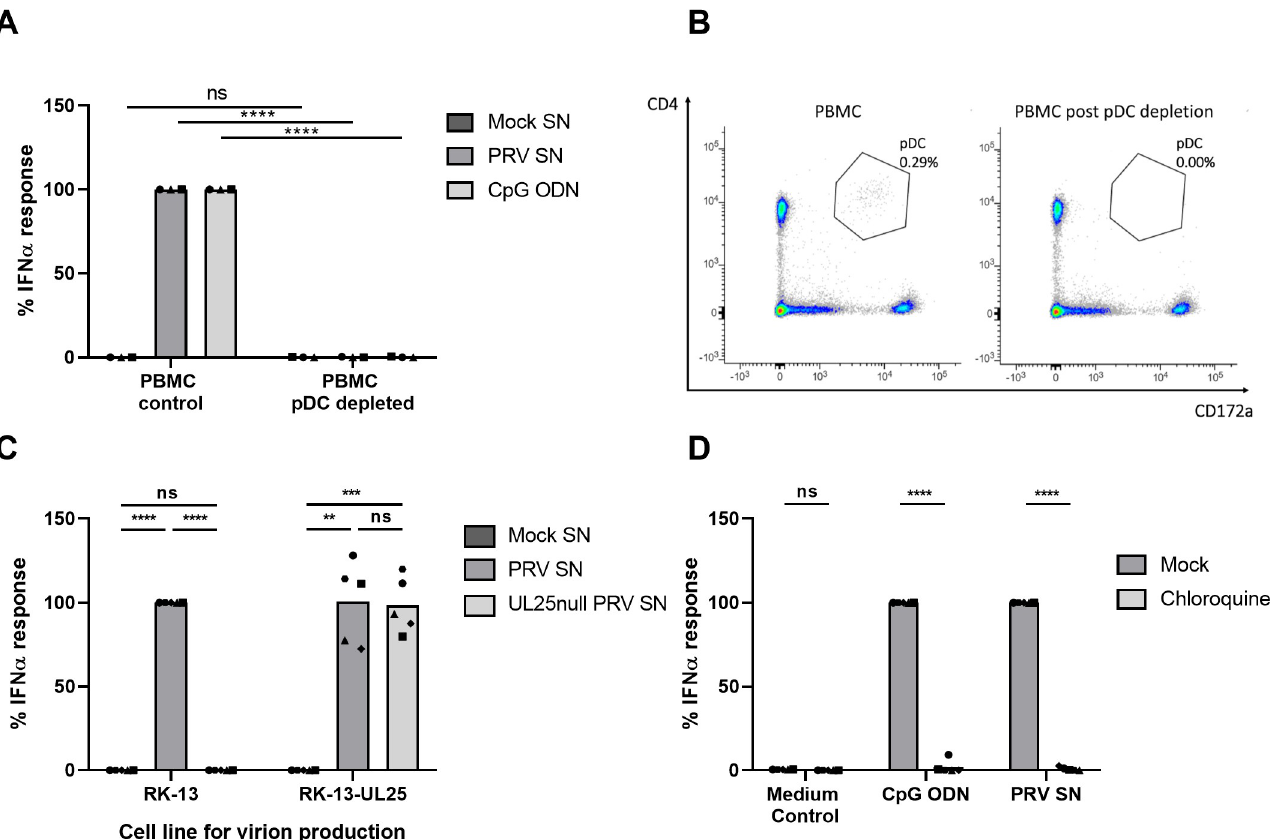
Fig 1. PRV-induced IFN α response by porcine PBMC depends on pDC, H-particles and endosomal acidification. (A) IFN α response of porcine PBMC either or not depleted for pDC upon stimulation with mock-, PRV supernatant (SN) or CpG ODN for 22h. PRV SN was collected from ST cells at 24hpi at a multiplicity of infection (MOI) of 10. IFN α levels were determined by ELISA. Data shown are normalized to the PBMC control response (set to 100) for each of the three independent repeats. (‘ns’ not significant, ‘ ���� ’ P < 0.0001). (B) Post FACS sort analysis of porcine PBMC with either live cells sorted (left) or all cells except pDC sorted (right). pDC are characterized as CD4 high CD172a dim and indicated by the gate. (C) IFN α response upon porcine PBMC stimulation for 22h with supernatant collected at 24hpi from parental RK-13 cells or UL25-expressing RK-13 cells that were either mock infected or infected with WT PRV Kaplan or its isogenic UL25null mutant. Data shown are normalized to the response of PBMC stimulated with WT PRV produced on RK-13 cells (set to 100) for each of the five independent repeats. (‘ns’ not significant, ‘ �� ’ P < 0.01, ‘ ��� ’ P < 0.001, ‘ ���� ’ P < 0.0001). (D) Porcine PBMC were mock-treated or treated with 10 μ M chloroquine for 1h at 37˚C followed by stimulation with CpG ODN, PRV SN or medium control for 22h. PRV SN was collected from ST cells at 24hpi at a multiplicity of infection (MOI) of 10. IFN α responses are depicted as normalized to the stimulus in the mock condition (set to 100) for each of the five independent repeats. (‘ns’ not significant, ‘ ���� ’ P <